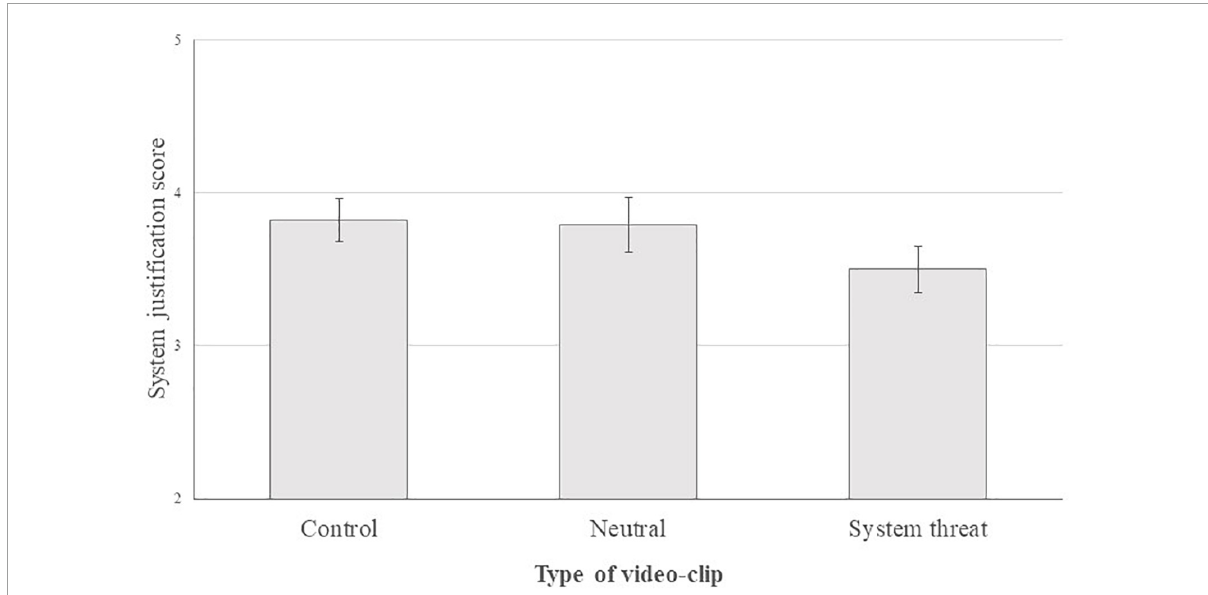
FIGURE1 System justification score depending on video-clip type. Errors bars indicate the standard